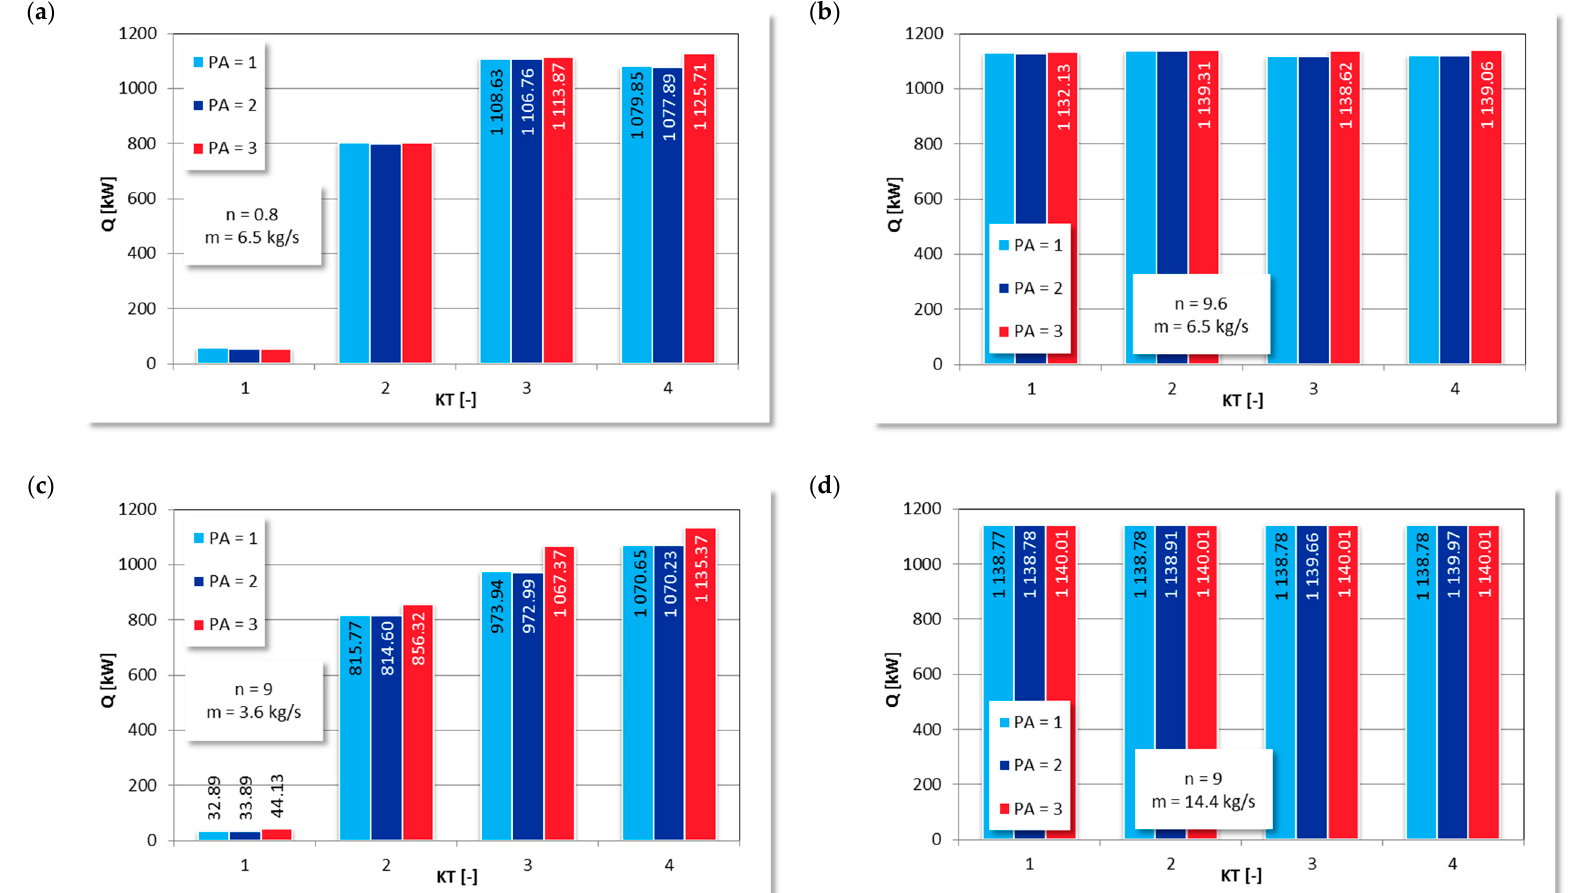
Figure 8. Effect of kind of tubes KT and tube pass arrangements PA on the heat transfer rate of the evaporator, for the different number of flooded heat transfer tube rows n (the top row) and liquid refrigerant mass flow rate m (the bottom row). ( a ) n = 0.8, m = 6.5 kg / s, ( b ) n = 9.6, m = 6.5 kg / s, ( c ) n = 9, m = 3.6 kg / s, ( d ) n = 9, m = 14.4 kg / s.